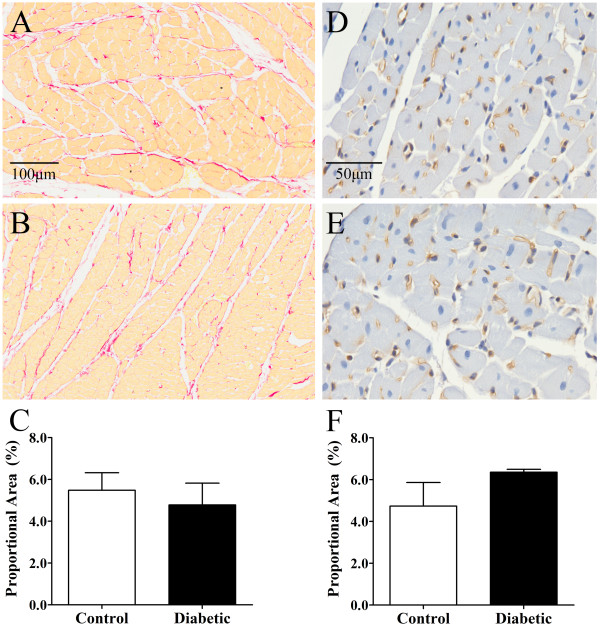
Myocardial interstitial collagen expression and capillary density in control and diabetic rats. Interstitial collagen accumulation (C) assessed via picrosirius red staining in control (A) and diabetic (B) rats (20× objective). Capillary density (F) assessed via isolectin B4 staining in control (D) and diabetic (E) rats (40× objective). There was no significant difference between groups. Control, n = 6 and diabetic, n = 8. Values expressed as mean ± SEM.